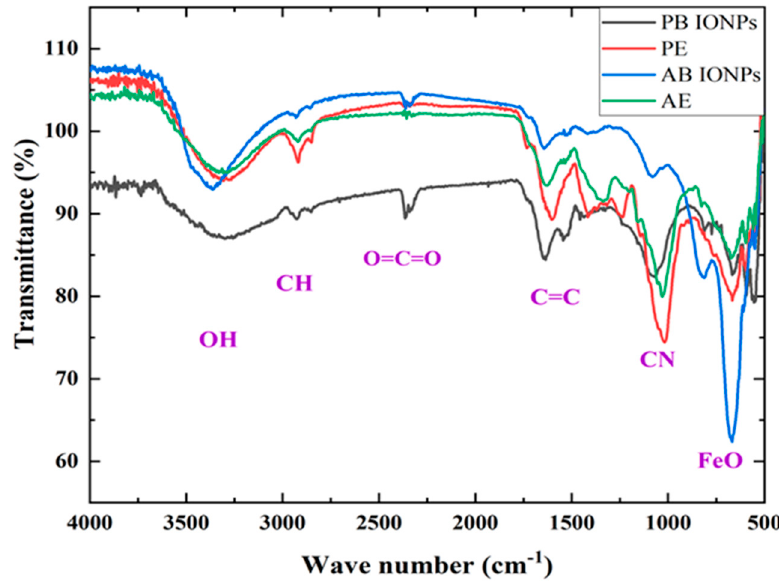
Figure 2. FTIR spectra of AE, PE, and biofabricated algal and plant based Fe 3 O 4 NPs show various functional groups for biomolecules from Ajuga bracteosa and Spirogyra hyalina involved in the bioreduction of NPs.